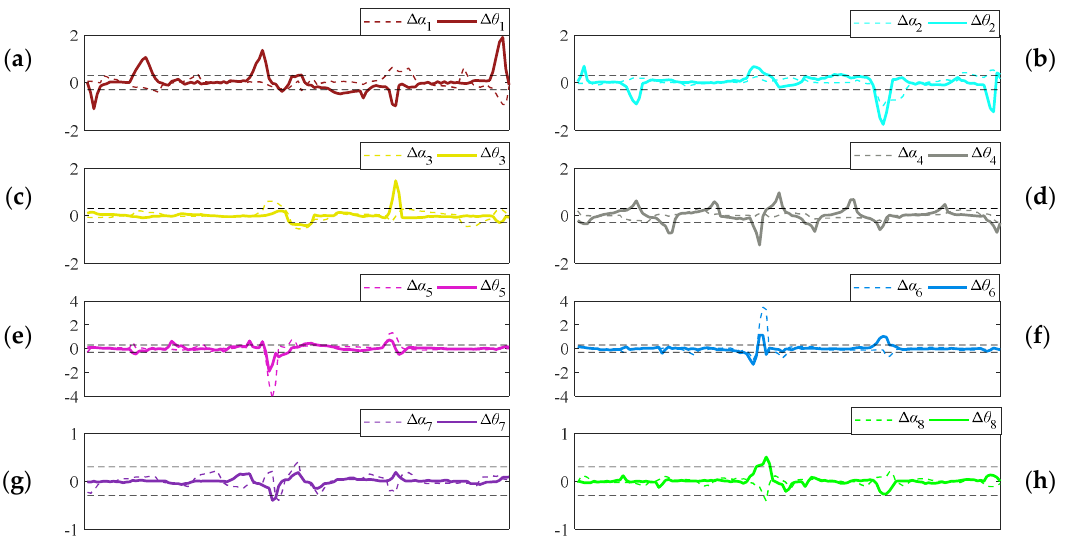
Figure 21. Diagram of the error values of the joint angles in the non−repeating path experiment. ( a )